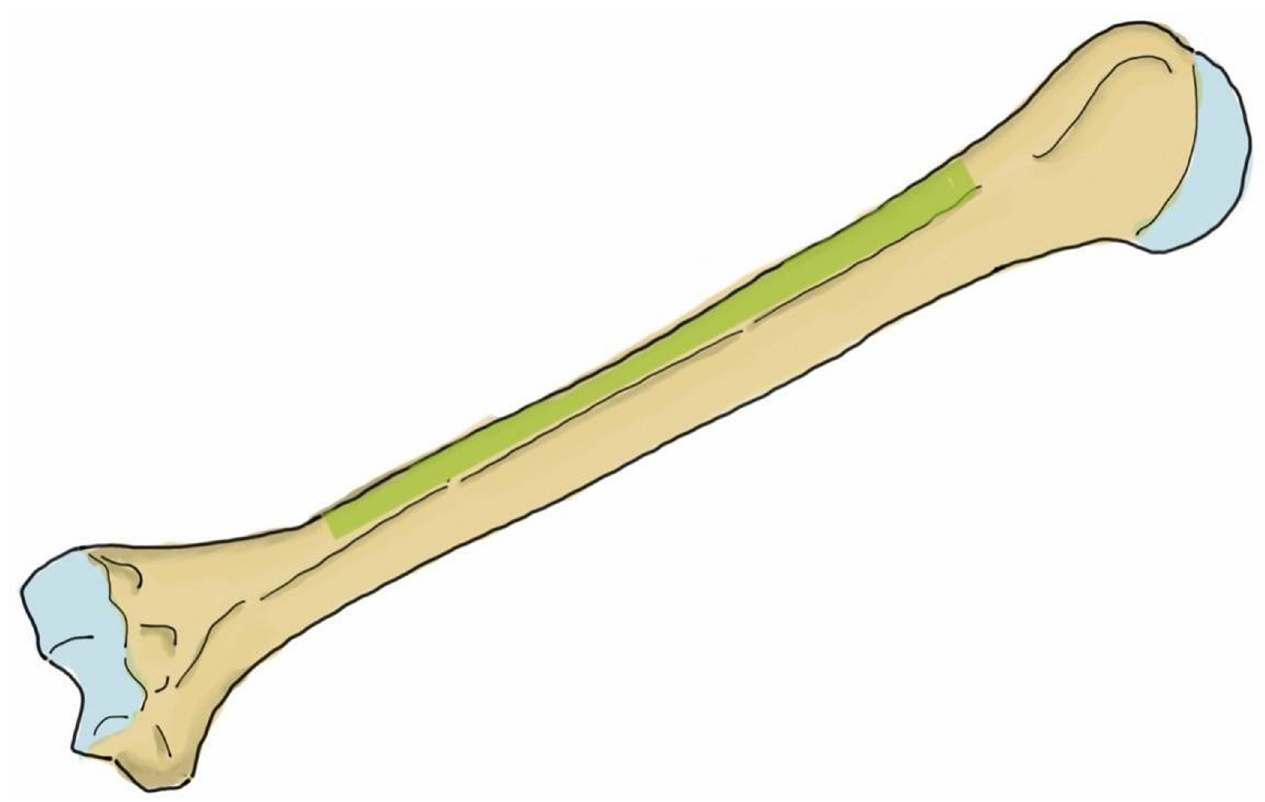
Fig 1. The anterolateral surface of the humerus (green shaded area) shows the area in which the plate can be applied.